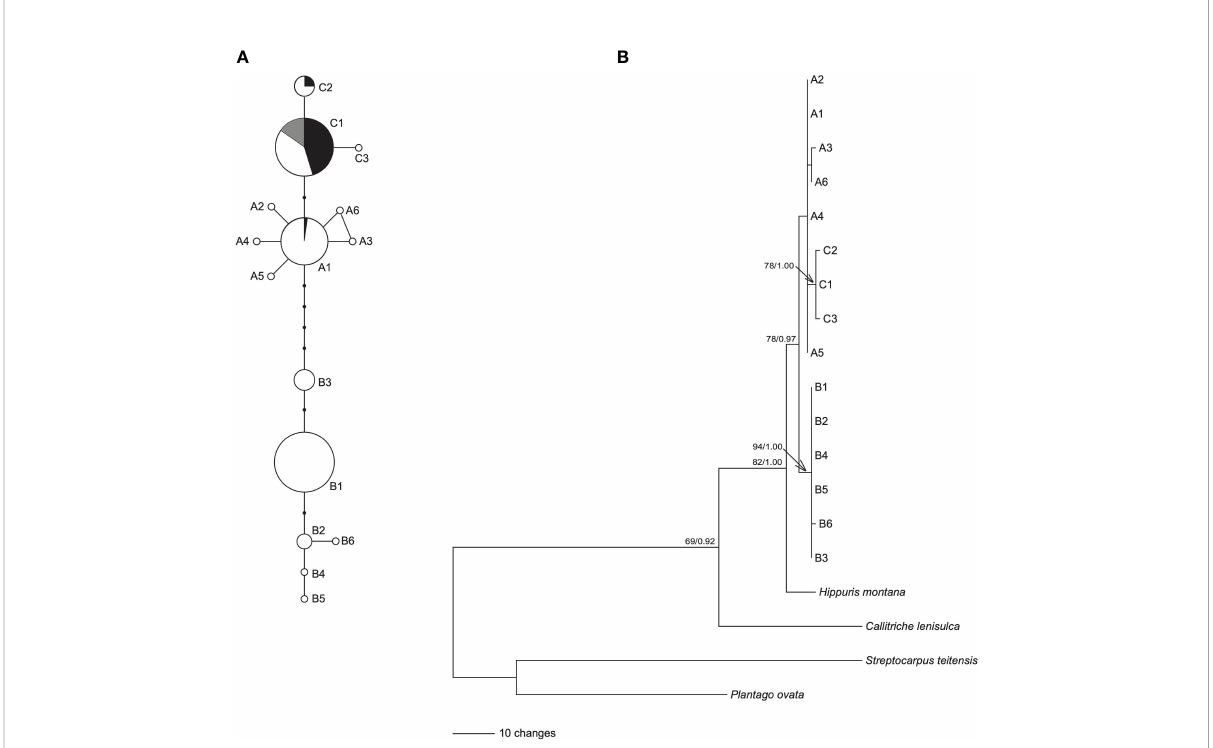
FIGURE 1 Network and phylogenetic tree of 15 cpDNA haplotypes of Hippuris vulgaris . (A) Network of genealogical relationships among the 15 cpDNA haplotypes. The black dots represent missing haplotypes. Three haplotypes, A1, C1 and C2, were also from ( H. lanceolata and H. tetraphylla , and their proportions were indicated by black and grey, respectively. (B) Phylogenetic tree of 15 cpDNA haplotypes inferred using GARLI. Numbers at nodes are the ML bootstrap values (BS) and Bayesian posterior probabilities (PP) in phylogeny reconstruction. The nodes without numbers indicate BS < 65 and PP <